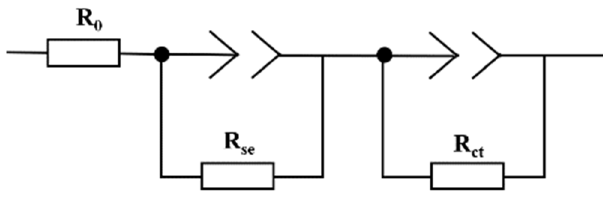
Figure 10. Equivalent circuit diagram of AC impedance.